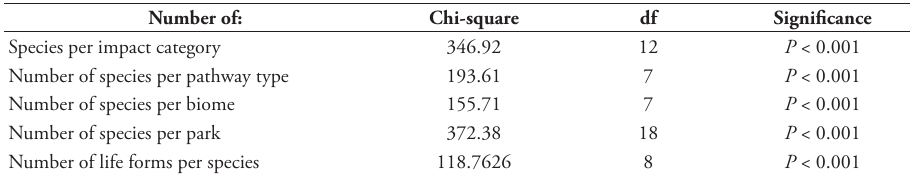
Table 3. Differences in numbers of transformer plant species per impact category, pathway, biome, park and life-form. (Chi-square test results for individual models), (See Figures 3,